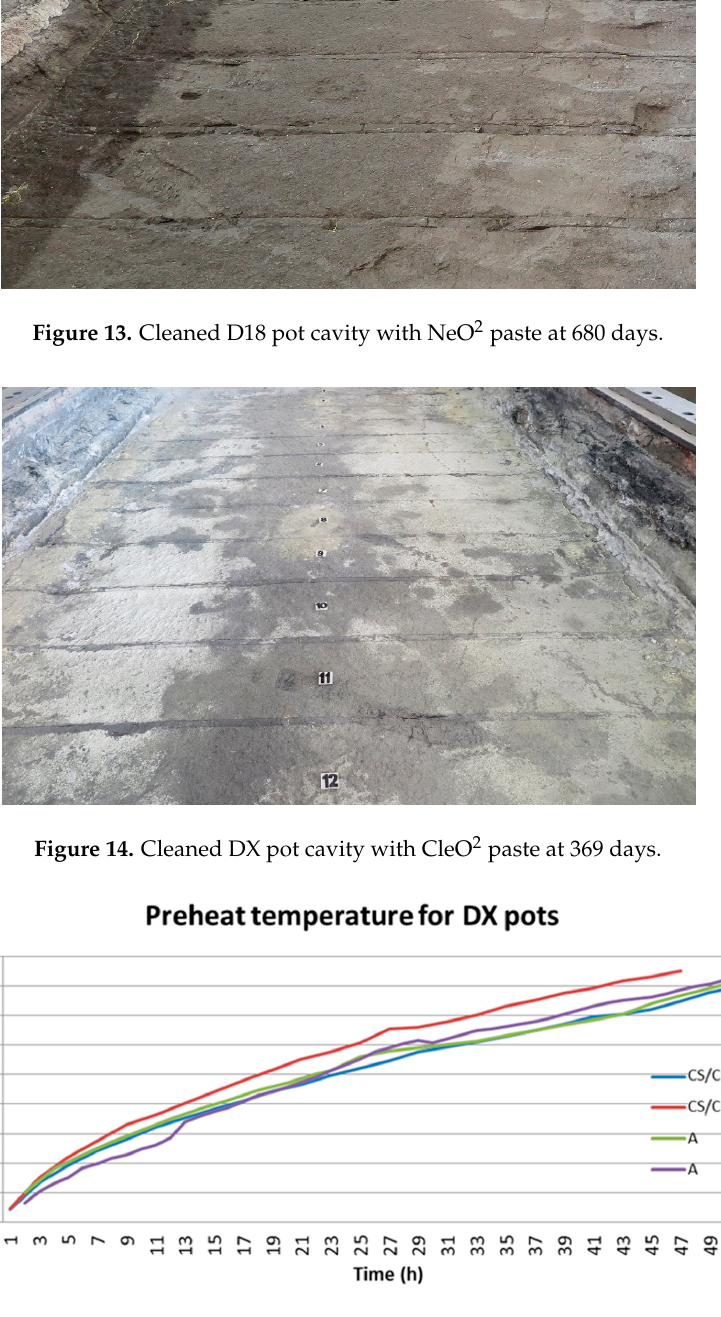
Figure 15. Preheat temperature for DX pots with different pastes.